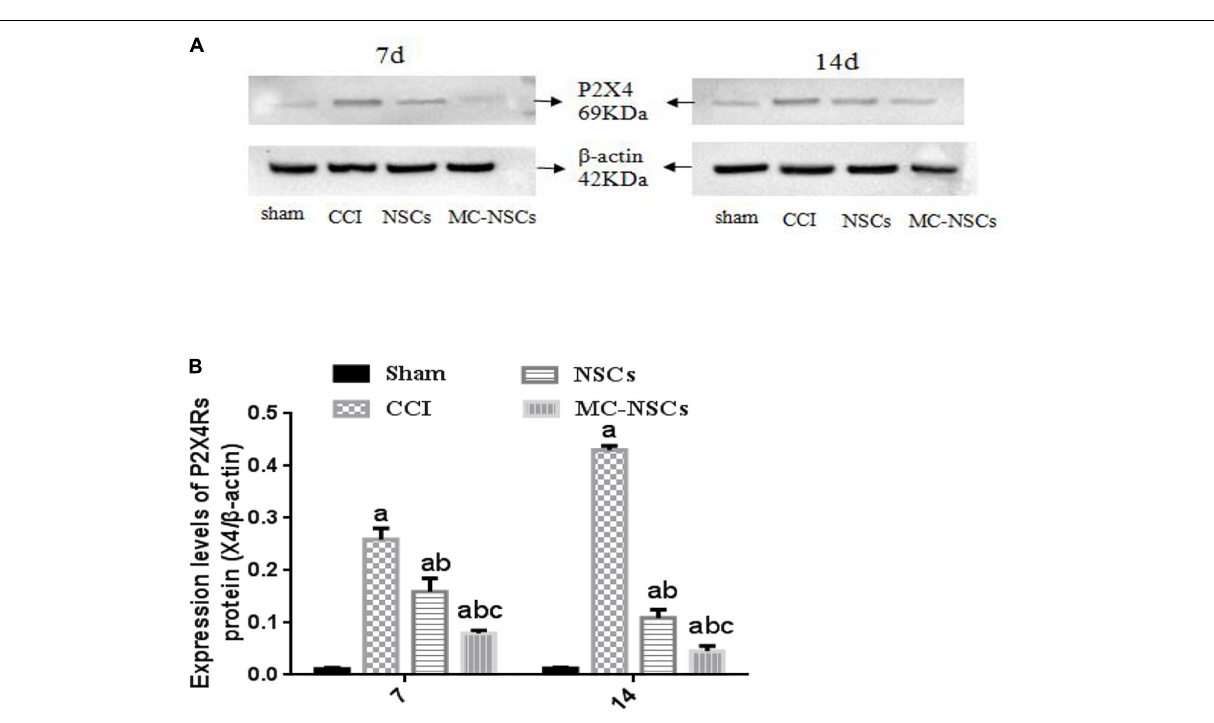
FIGURE 3 | Behavioral methods were used to detect the mechanical withdrawal threshold (MWT) and thermal withdrawal latency (TWL) of rats in each group. (A,B) The MWT and TWL of rats from high to low was found in the sham, MC-NSC, NSC, and CCI groups (all p -values < 0.05), while compared with the NSCs group, the MWT and TWL of rats in the MC-NSC group were increased ( p < 0.05). Data were expressed as the mean ± SD ( n = 6), a p < 0.05 vs. sham group; b p < 0.05 vs. CCI group; c p < 0.05 vs. NSC group.